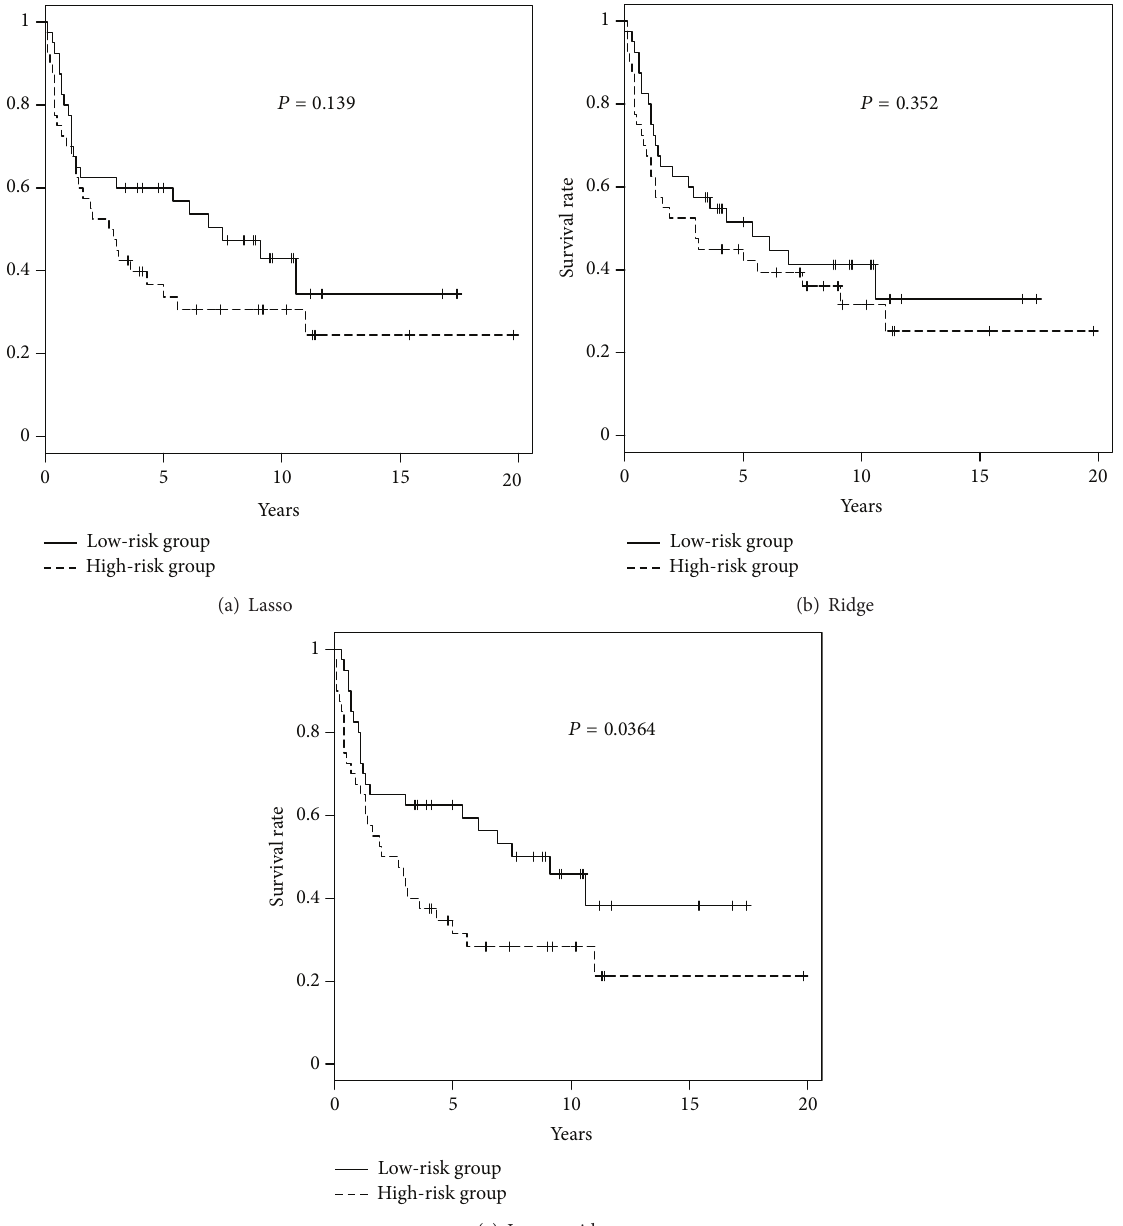
Figure 3: The Kaplan-Meier curve results of three penalized regression models, lasso, ridge, and elastic net, for low- and high- risk groups,